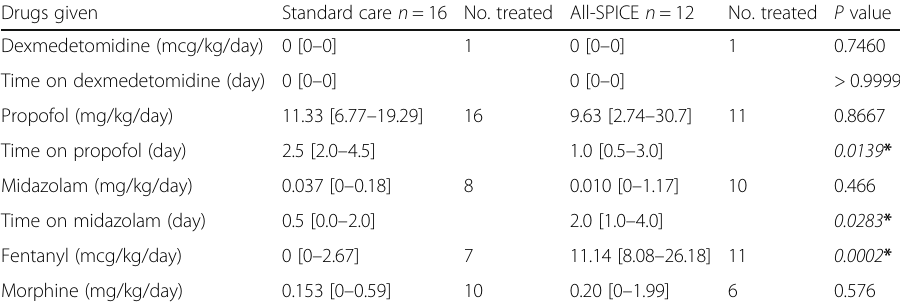
Table 4 Cumulative dose/kg body weight and duration of treatment with sedatives and analgesic agents throughout the study period Drugs